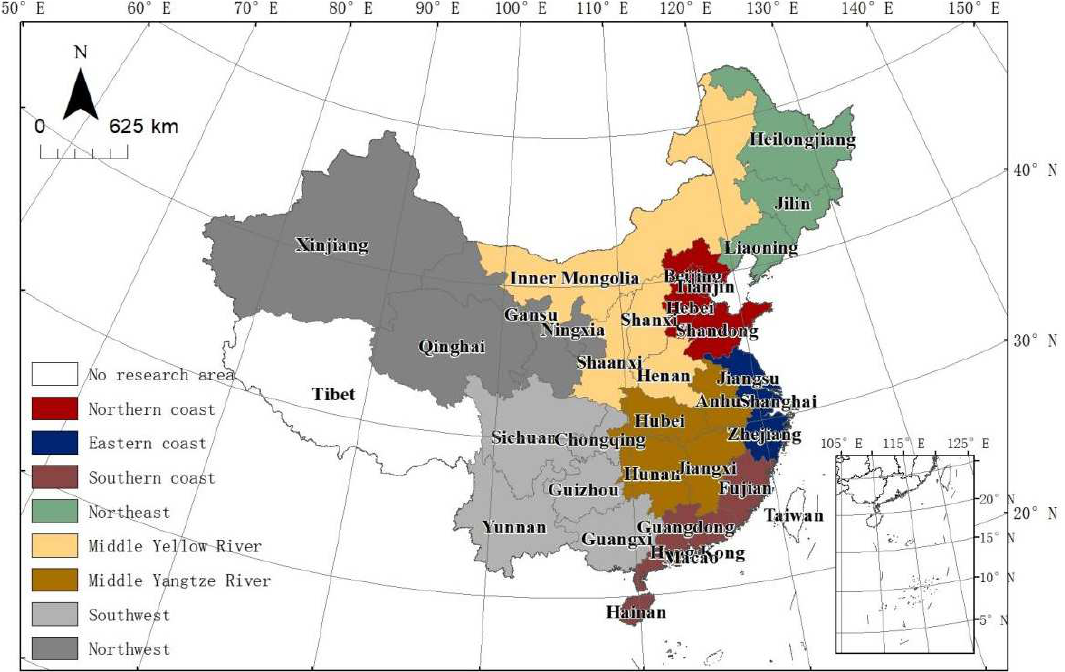
Figure 1. The schematic diagram of eight economic zones of